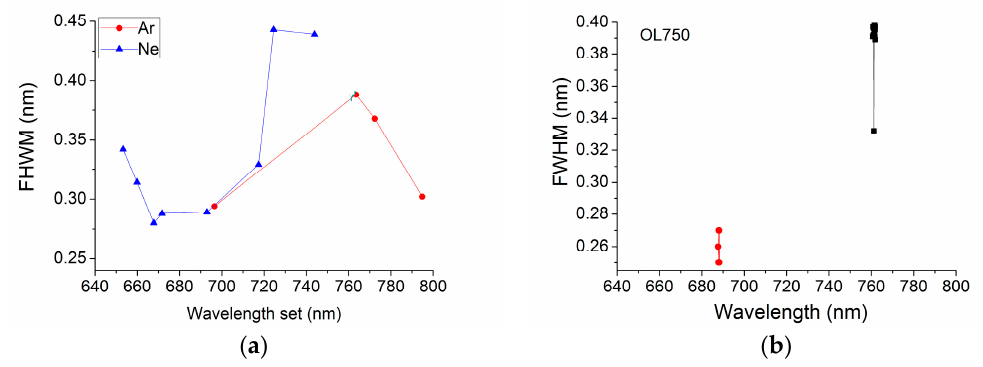
Figure 14. The FWHM values as determined from the Gaussian fit applied to the QEP00114 signal corresponding to the ( a ) Ar/Ne and ( b ) OL750D emission.